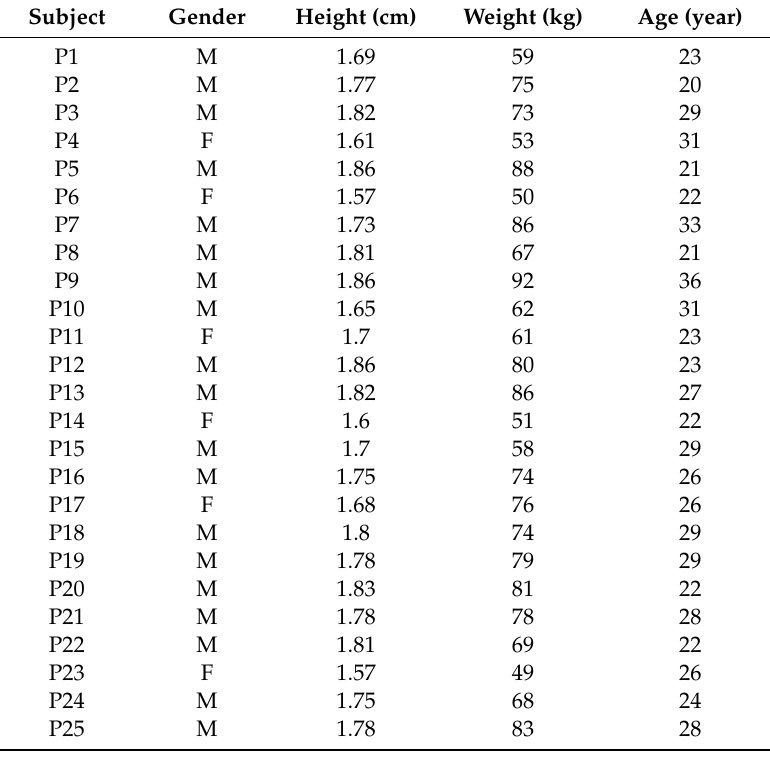
Table 1. General physical information of the participants (test subjects).